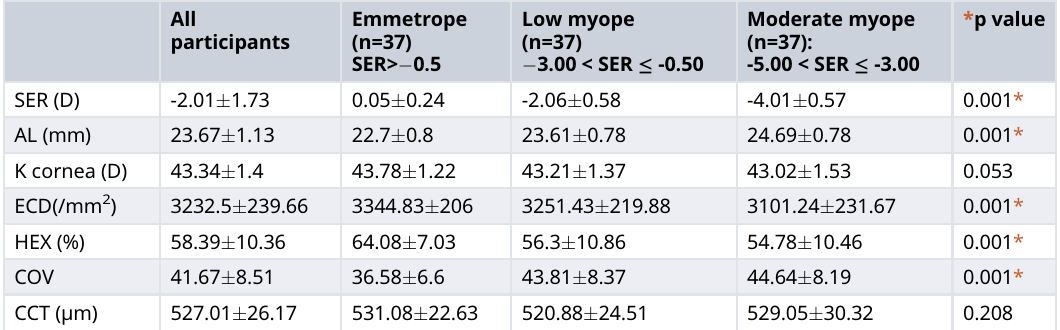
Table 2. AL and CEC parameters (ECD, HEX, COV, and CCT) between different refractive groups. All